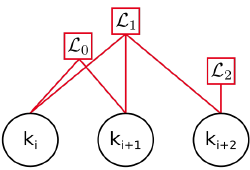
Figure 2: Leakage model with the leakage of bits overlapping in the